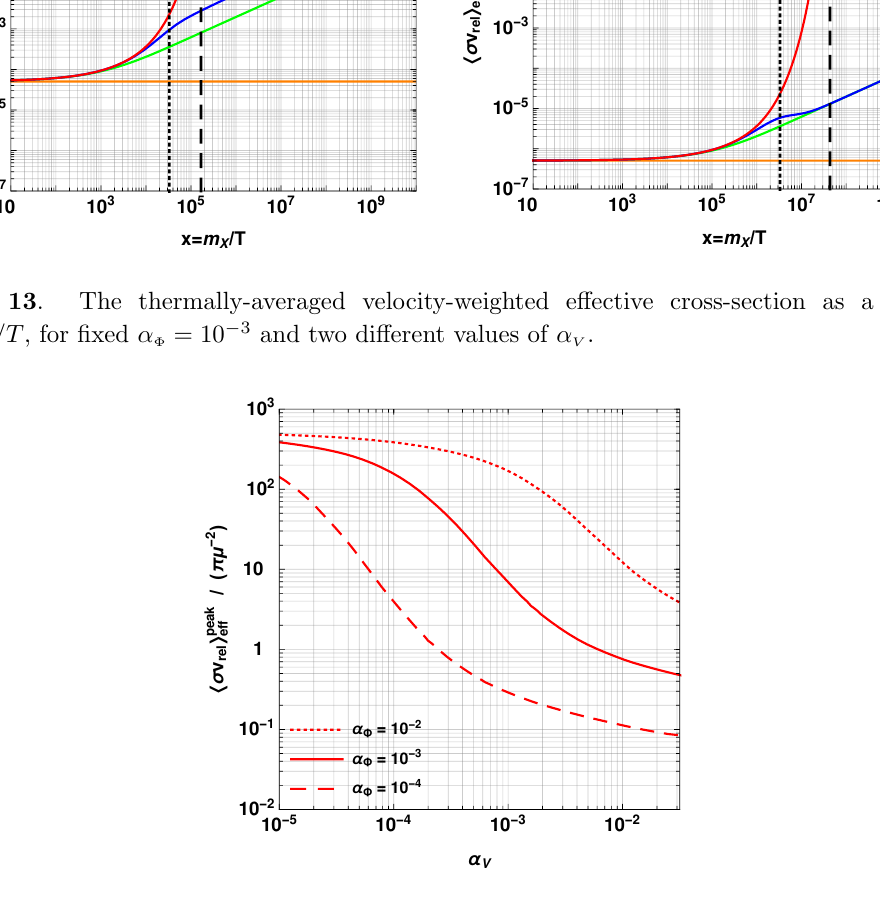
Figure 14 . The value of the thermally averaged velocity-weighted e(cid:11)ective cross-section at its peak as a function of (cid:11) x = x peak , depends on (cid:11) h (cid:27)v rel i peak